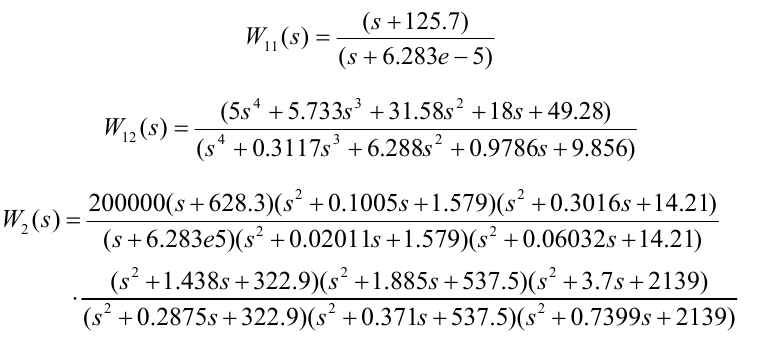
Figure 10. Weight functions for the H